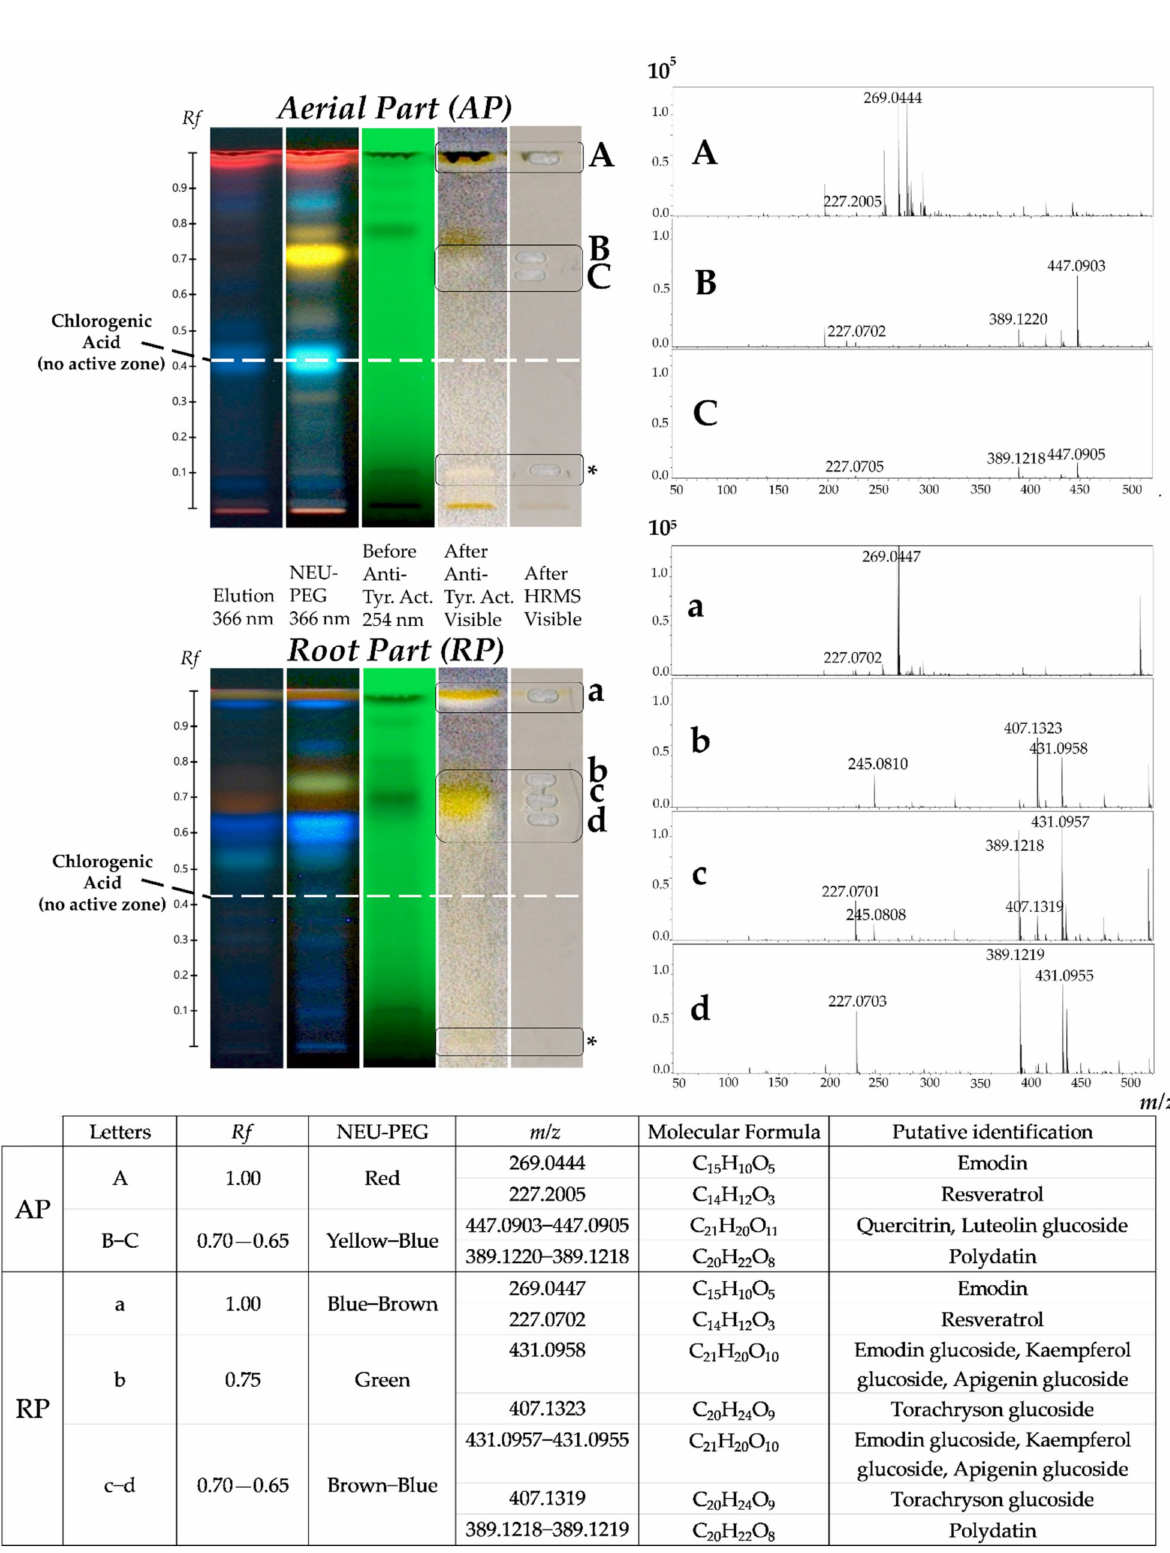
Figure 4. Detection of three active zones in AP and three active zones in RP on tyrosinase (Tyr.) circled in black on the plate. Putative identification of potential tyrosinase inhibitors using HPTLC- Bioautography/HRMS in the negative ionization mode; zones marked with a letter. Mobile phase: EtOAc:FA:AcOH:H 2 O (100:11:11:27) ( v:v:v:v ). Act. = Activity. Rf = Retention factor. NEU-PEG: chemical derivatizations NEU then PEG. m/z : mass-to-charge ratio. * Not